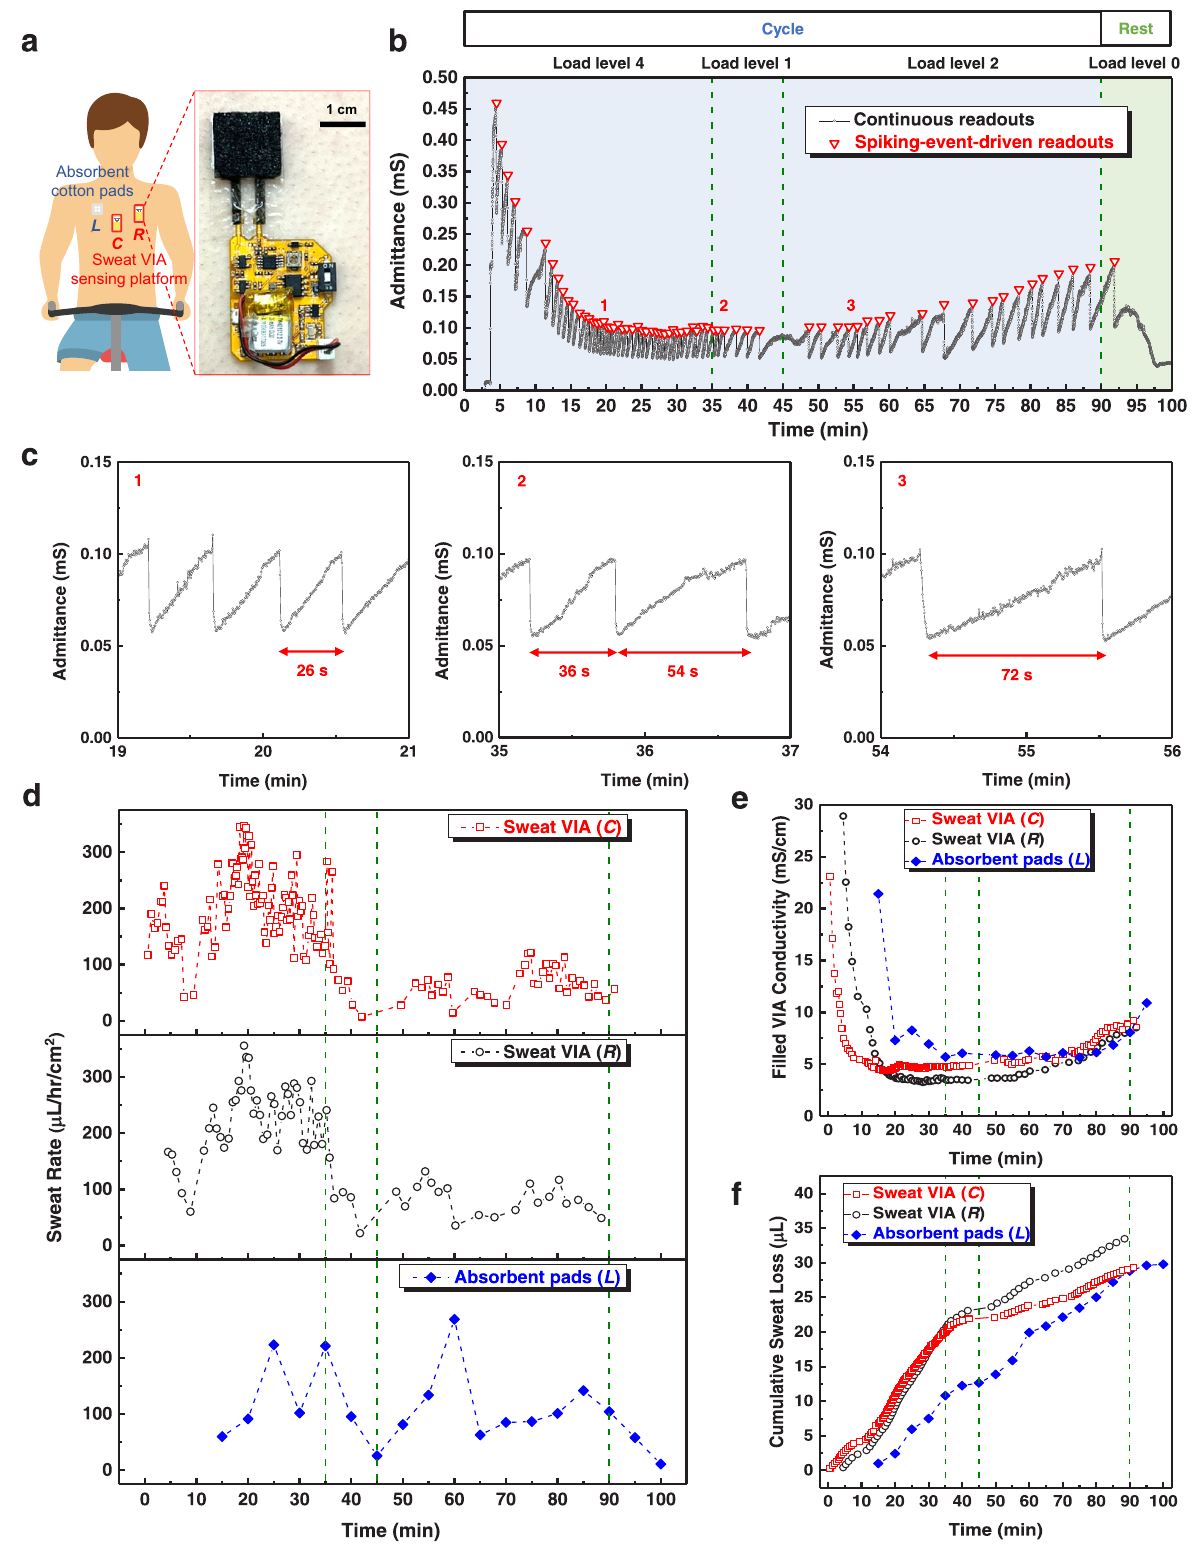
Fig. 6 | On-body study of event-driven wireless monitoring of epidermal per- spiration. a Schematic and photographic images of the on-body study using the sweat VIA-based epi fl uidic wireless patches ( C , R ) and absorbent cotton pads ( L ) attachedtotheindicatedchestskinareas. C :center, R :right, L :leftareaofthechest skin. b AdmittancevaluesofthesweatVIAsensorcalculatedusingwirelessreadouts transmitted in continuous (black line) and spiking-event-driven (red inverted tri- angle)mannersduringtheentireexercisesequenceof100minwithvariouscycling load levels, with the higher number indicating a harder exercise load. c Enlarged